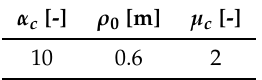
Table 2. Values of the parameters of the virtual force implemented to avoid